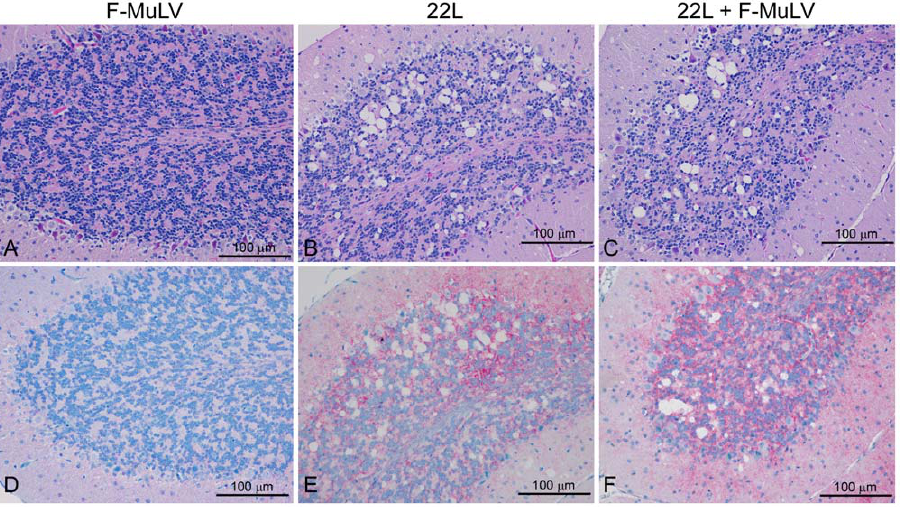
Figure 5. Vacuolation and PrPS c deposition in the brain is the same in mice infected with 22L or 22L plus FV. (A–C) Hemotoxylin and eosin staining of the cerebellum from (B10 X A.BY)F1 mice inoculated (A) i.v. with FV alone, (B) i.p. with mouse 22L mouse scrapie alone, or (C) co- infected with 22L mouse scrapie i.p. and FV i.v.. Magnification=200 6 . (D–F) PrP Sc deposition in the cerebellum of (B10 X A.BY)F1 mice inoculated (D) i.v. with FV alone, (E) i.p. with mouse 22L mouse scrapie alone, or (F) co-infected with 22L mouse scrapie i.p. and FV i.v.. Sections were stained using the anti-PrP mouse monoclonal antibody D13 following hydrated autoclaving at high pressure and temperature. Red stain indicates the presence of PrP Sc . Magnification=200 6 .